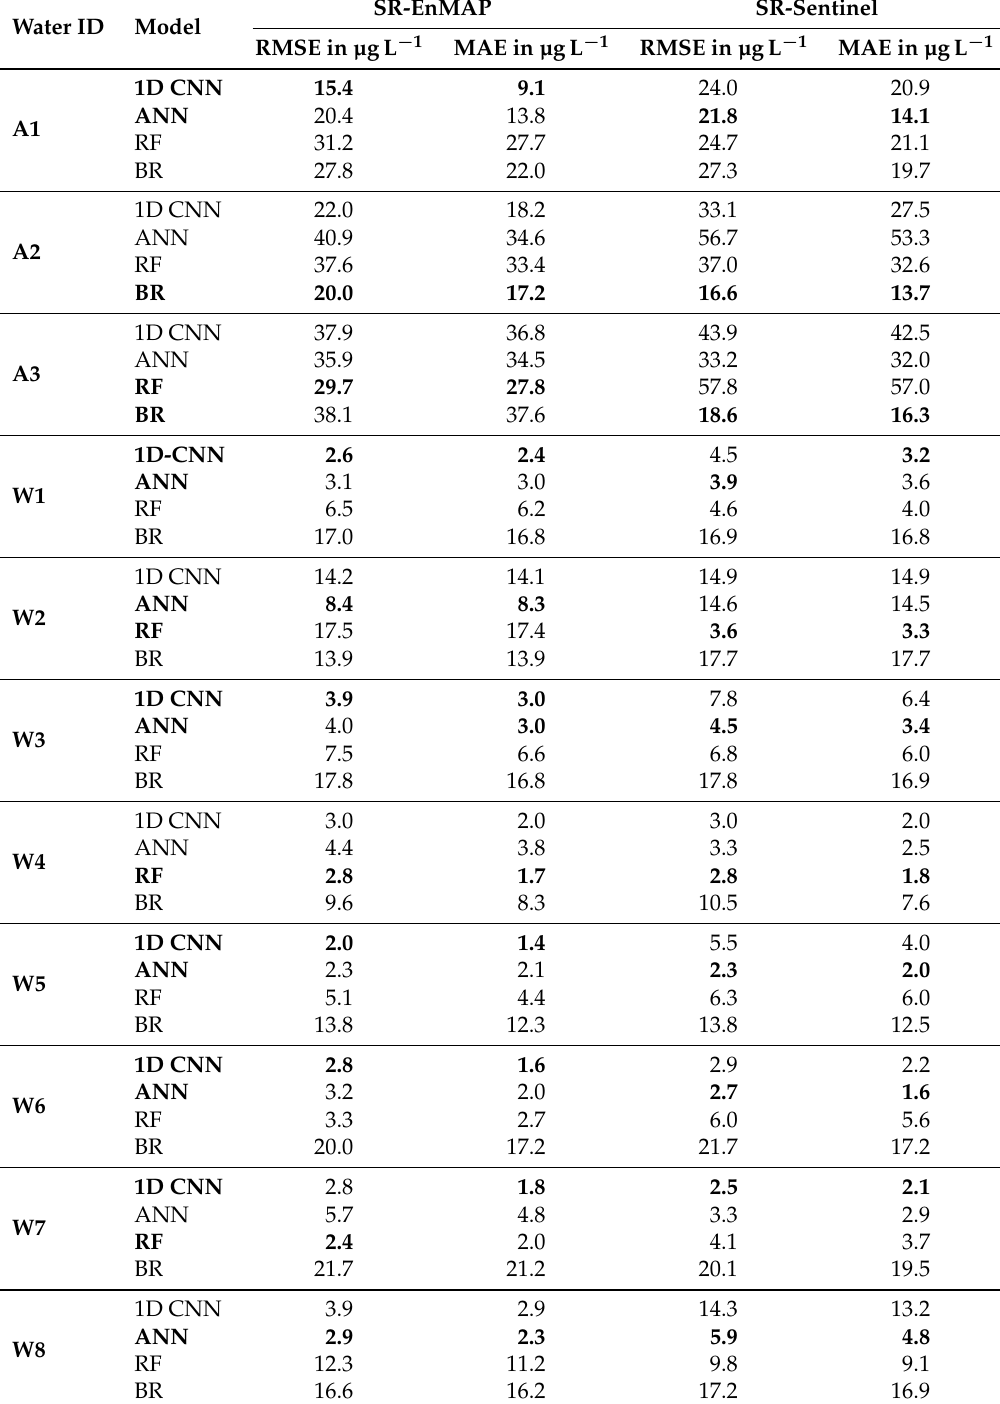
Table 5. Results for the chlorophyll a estimation of the SpecWa inland water